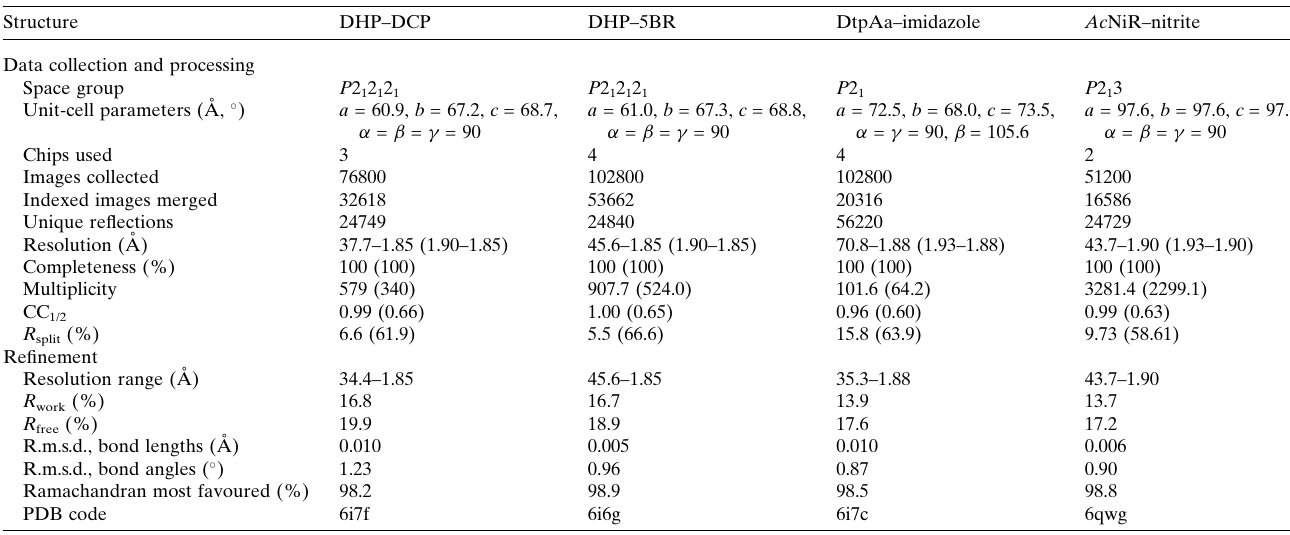
Table 1 Data-collection, processing and refinement statistics for full SFX data sets for enzyme–ligand complexes. Values in parentheses are for the outermost resolution